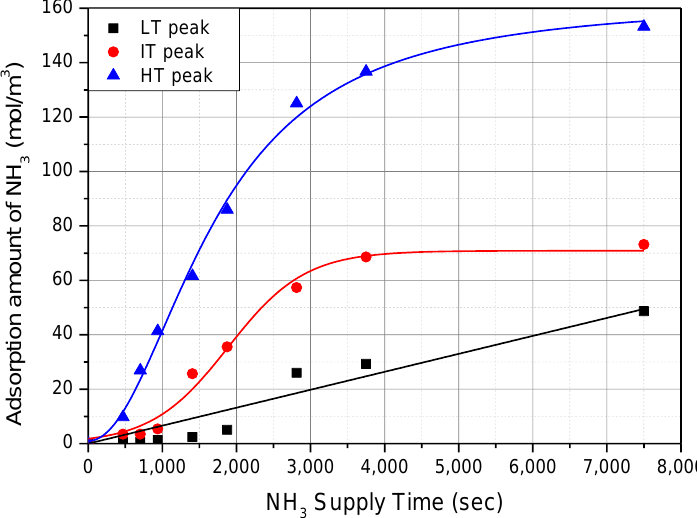
Figure 6. Change in the amount of NH 3 adsorption of each peak with respect to NH 3 supply time (inlet NH 3 concentration: 200 ppm, temperature of NH 3 absorbing: 50 °C).